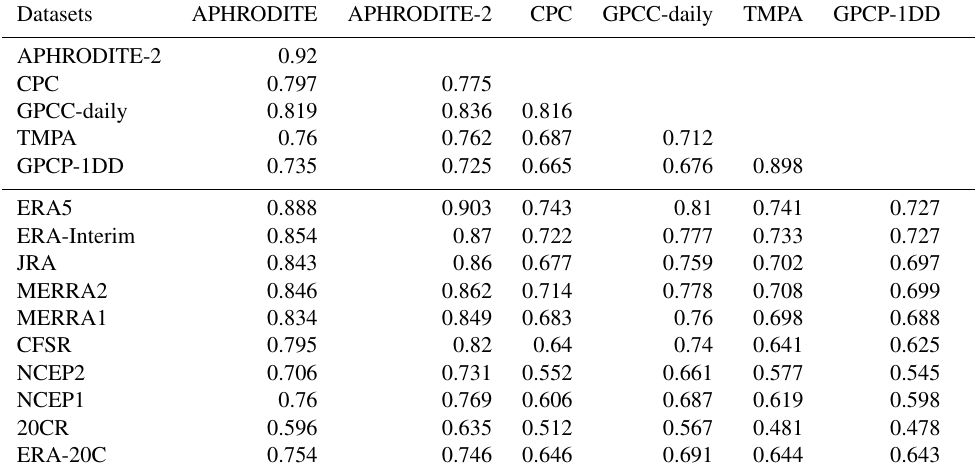
Figure 4. Daily correlation, per year, between CPC and Aphrodite (a, c) , and MERRA2 (b, d) for both the upper Indus (a, b) and lower Indus (c, d) . The green line is the correlation between the same days in each dataset. For the red line, the previous day of CPC is used instead. The black vertical line is the start of the year 1998, around where the main error should be. Table 6. Daily correlation between different datasets, in the upper Indus for the period 1998–2007.